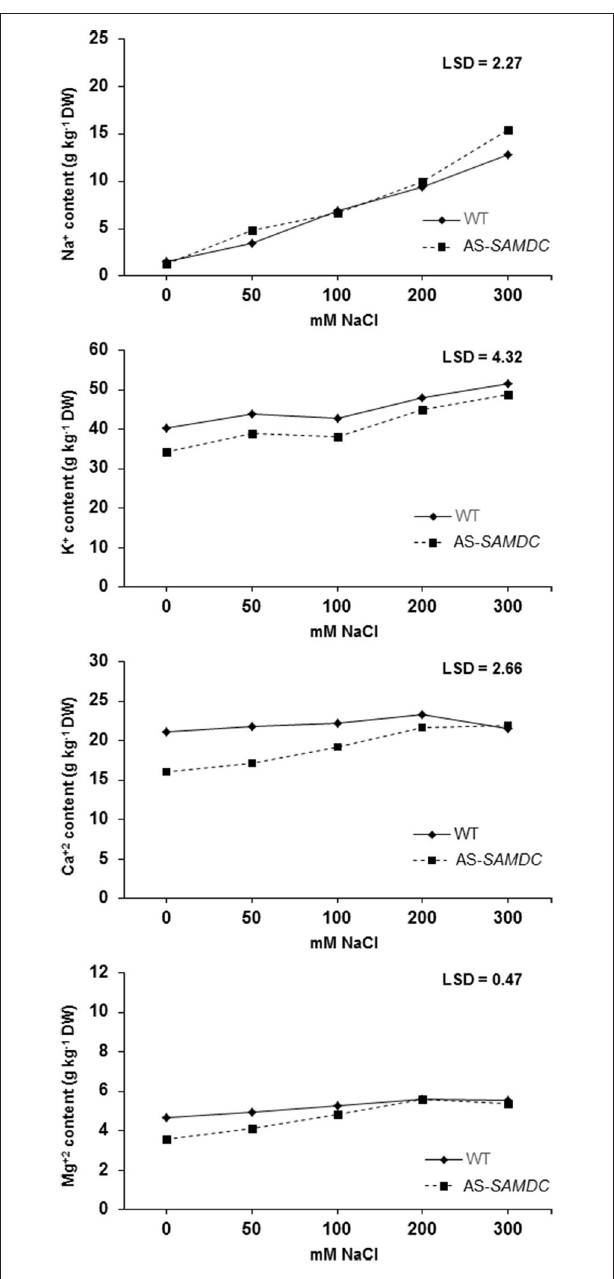
FIGURE 10 | Ion accumulation in the leaf tissue of WT and AS- SAMDC under control and NaCl treatment. Accumulation of Na + , Cl − , Ca 2 + , Mg 2 + in the leaves of WT and AS- SAMDC plants at different NaCl concentrations (0, 50, 100, 200, 300mM). Means are averaged over the whole experimental period, and each data point corresponds to the average of 9 observations [i.e., 3 replications per genotype per sampling date (7, 14, and 21 DAT)]. Fisher’s Protected LSD procedures was used to determine statistical differences between genotypes and treatments at a 5% significance level.